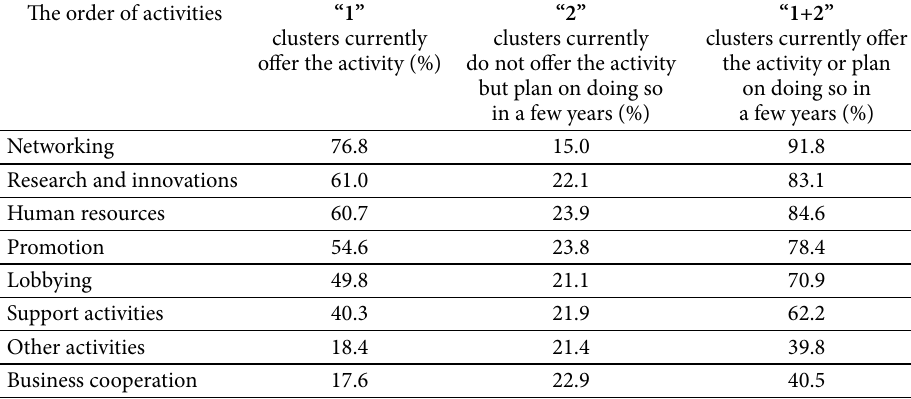
Table 1. Evaluation of implementation of activities (regardless of cluster age) The order of